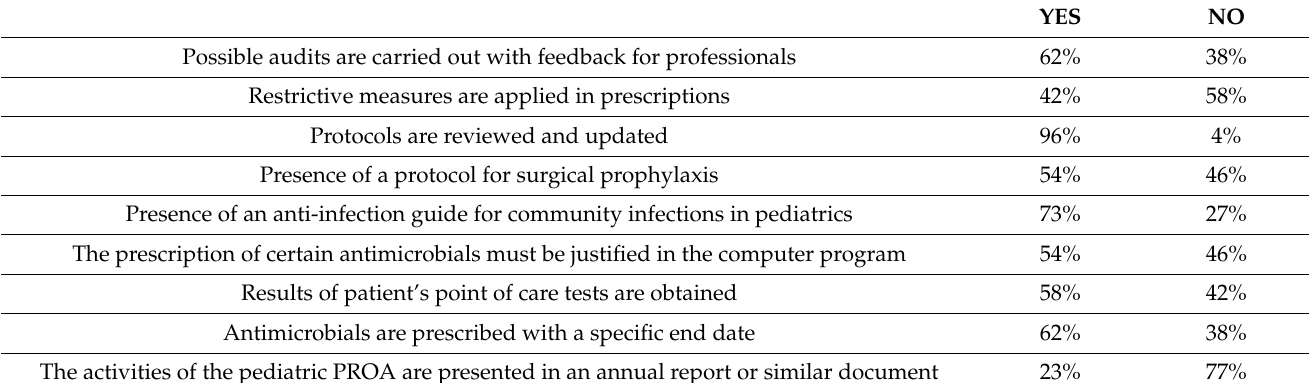
Table 3. Specific PROA actions at the hospitals participating in the VINCat pediatric